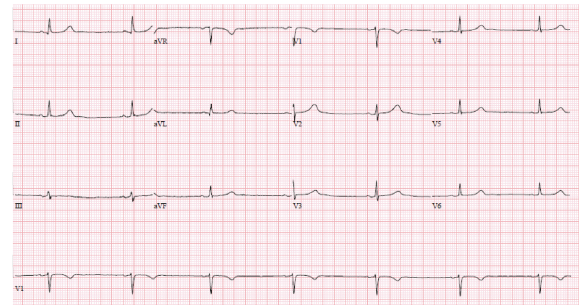
Figure 1: EKG of the patient on admission. This EKG shows marked sinus bradycardia with borderline low voltage QRS (QRS amplitude max: 7 mm in limb leads and 8 mm in precordial leads; HR: 41 beats/min (R-R interval: 1460ms); PR: 146ms; QRS 76 ms; QT/QTc 518/427